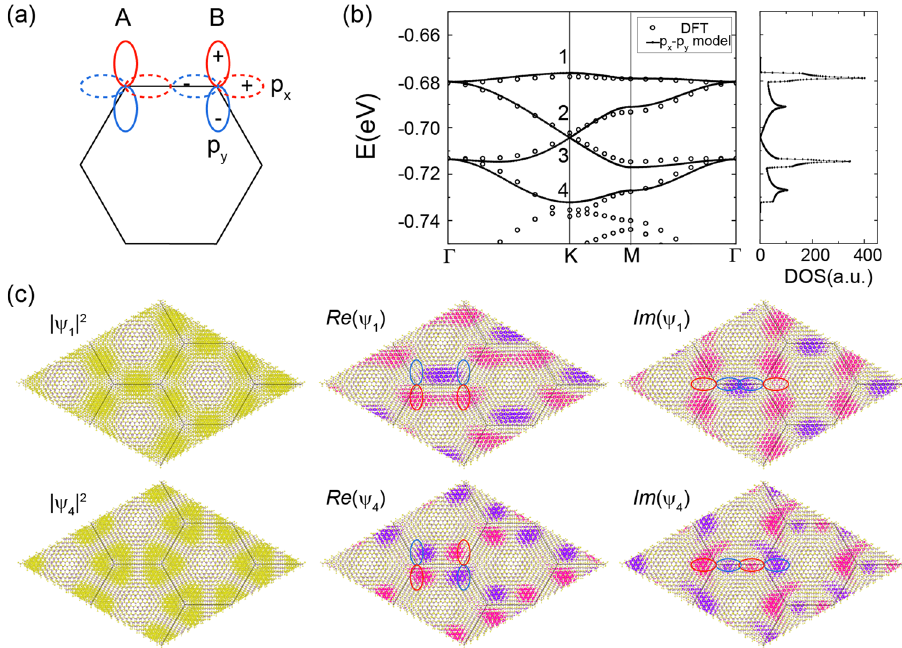
Fig. 2 p x -p y honeycomb model for twisted bilayer MoS 2 . a Illustration of the model: in a honeycomb lattice composed of sublattices A and B, there are two orthogonal orbitals (p x and p y ) at each of the two sublattice sites. The solid and the dashed lines denote the p y and the p x orbitals, respectively, and the red and the blue color denotes the positive and the negative side of the orbital, respectively. b Fitting the dispersion of the p x -p y model to the second set of valence bands of tbMoS 2 calculated with DFT for tbMoS 2 at 2.65°. The left panel shows the corresponding density of states displaying the signature four- peak structure. c Charge density, real and imaginary parts of the wave function calculated with DFT for the states in the two quasi- fl at bands 1 and 4 shown in ( b ). The isosurface of the charge density is colored yellow. The positive and the negative parts of the isosurfaces of the wave function are colored in pink and purple, respectively. The solutions of the corresponding states from the p x – p y model are indicated with the blue and red ovals and agree with the DFT